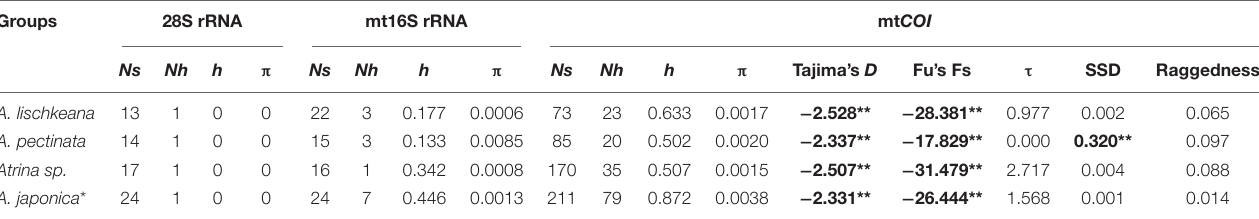
TABLE 2 | Summary of molecular diversity of 28S rRNA, mt16S rRNA, and mt COI and results of population expansion tests based on mt COI for various species of A. pectinata species complex. Groups 28S rRNA mt16S rRNA